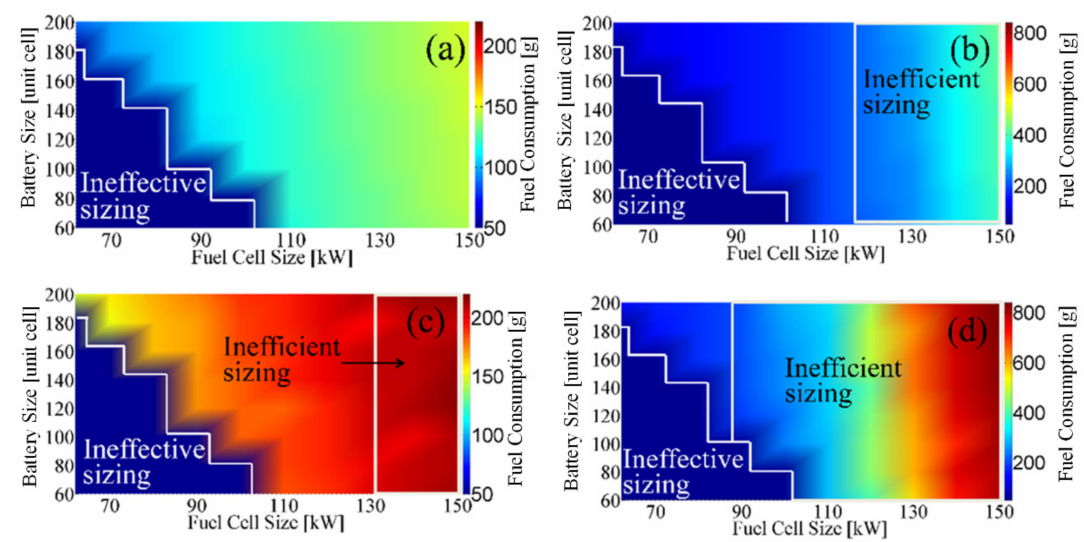
Figure 4. Power source sizing maps under driving cycles with different SOC ranges: ( a ) FTP-72 driving cycle, SOC 0.2–0.8; ( b ) FTP-72 driving cycle, SOC 0.5–0.6; ( c ) US06 driving cycle, SOC 0.2–0.8; ( d ) US06 driving cycle, SOC